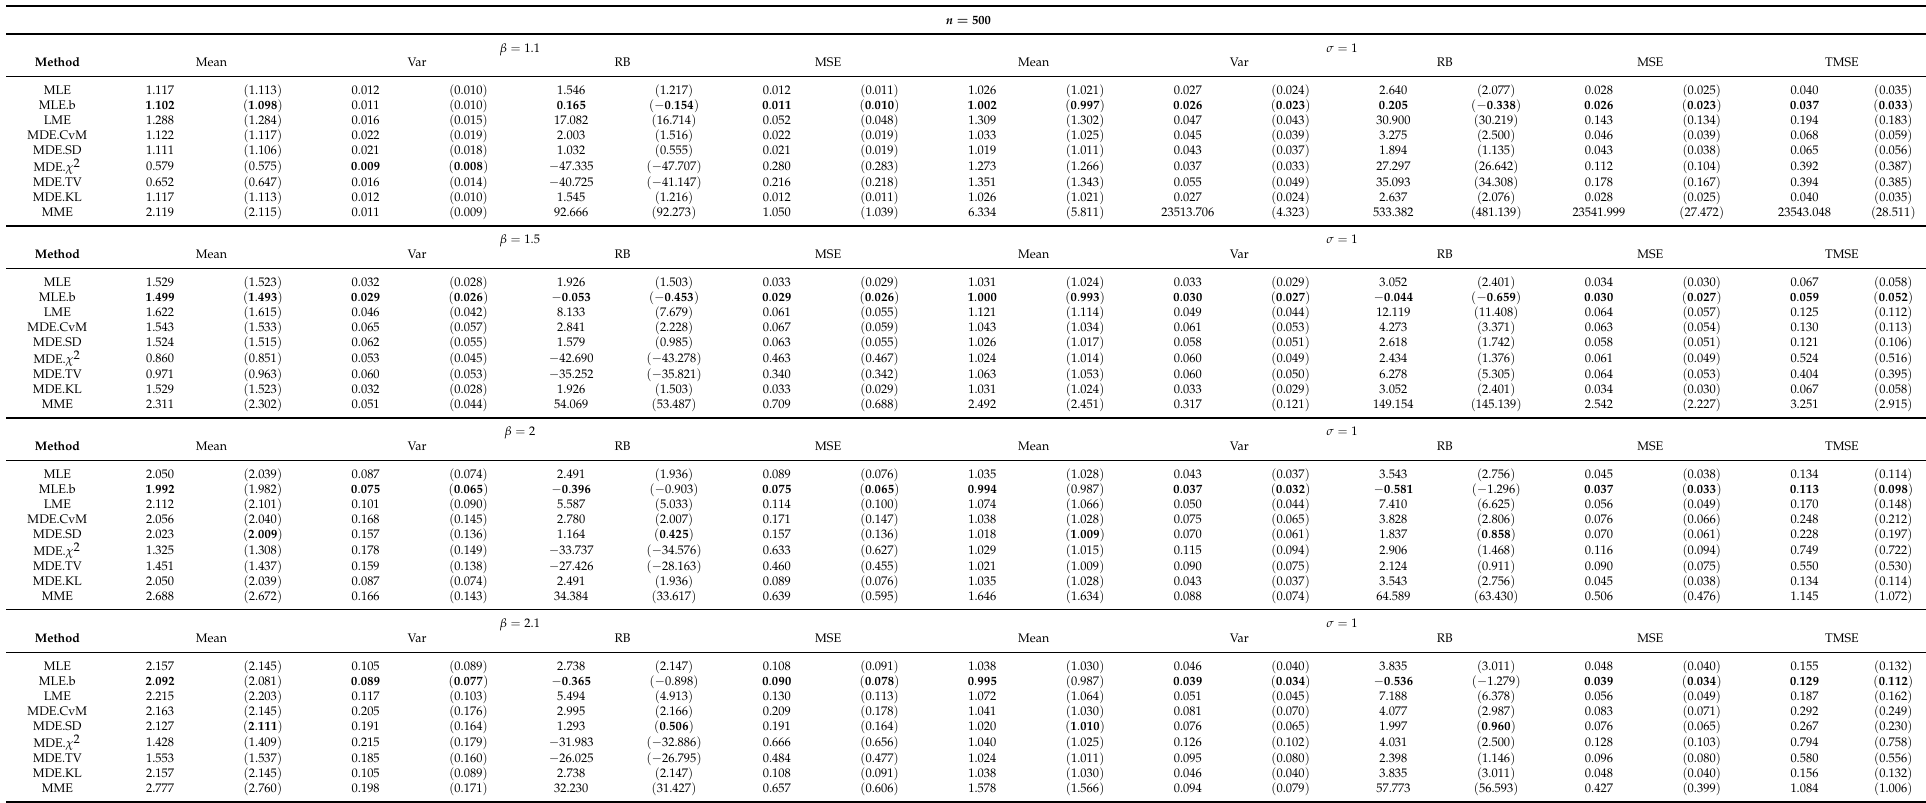
Table A5. Comparison of different estimation methods for different values of β ( σ = 1 and n =